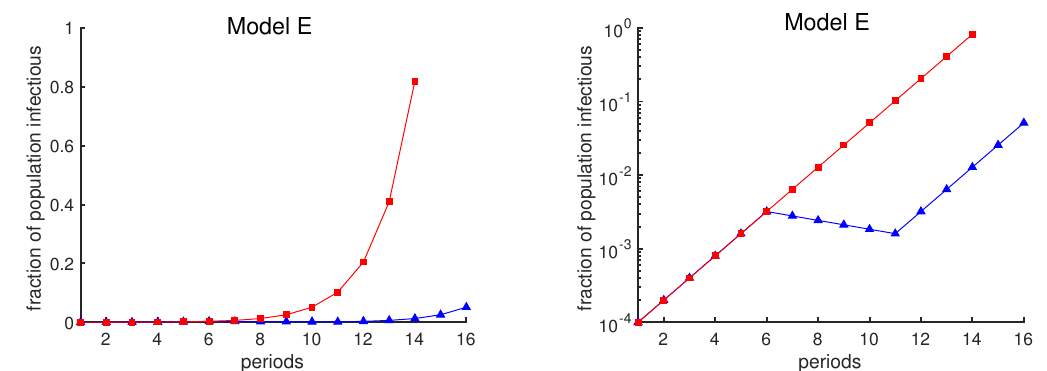
Figure 1. Fraction of the population that is infectious using Model E. Both curves show the fraction of the population that is infectious. One period is the average time interval between successive infection generations. The red curve assumes a contact rate of β = 2. The blue curve illustrates the effect of an intervention, undertaken between periods 6 and 11, that temporarily reduces the contact rate below 1. The same data are plotted in both panels; the vertical axis is a linear scale on the left and a logarithmic scale on the